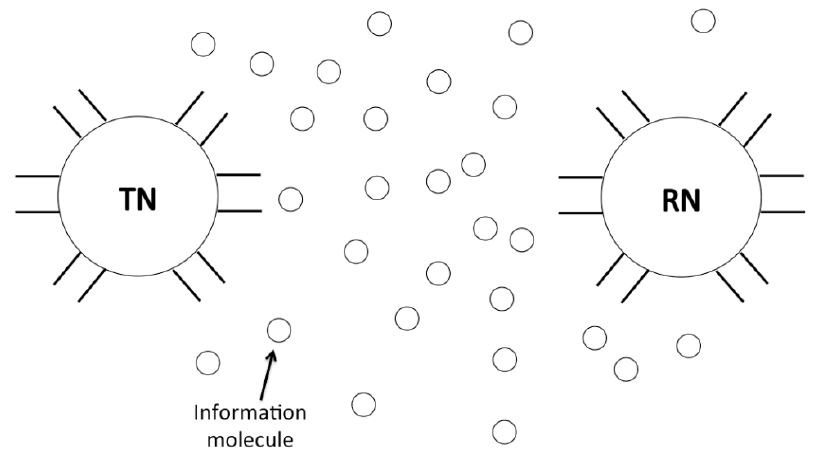
Figure 1. A typical molecular communication system in a bionnanosensor network.